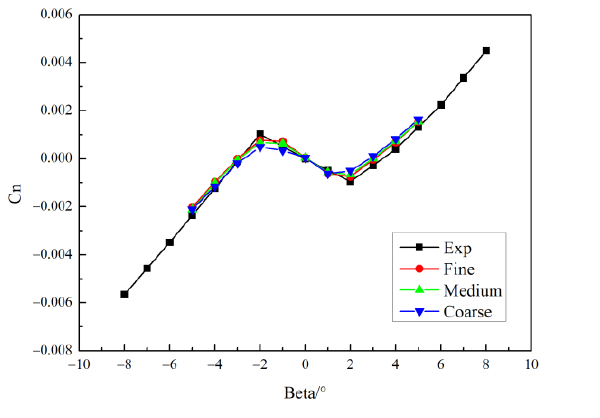
Figure 9. ( a ) Surface mesh of whole demonstration aircraft with a coarse gird. ( b ) Surface mesh of the T-tail with a fine grid.